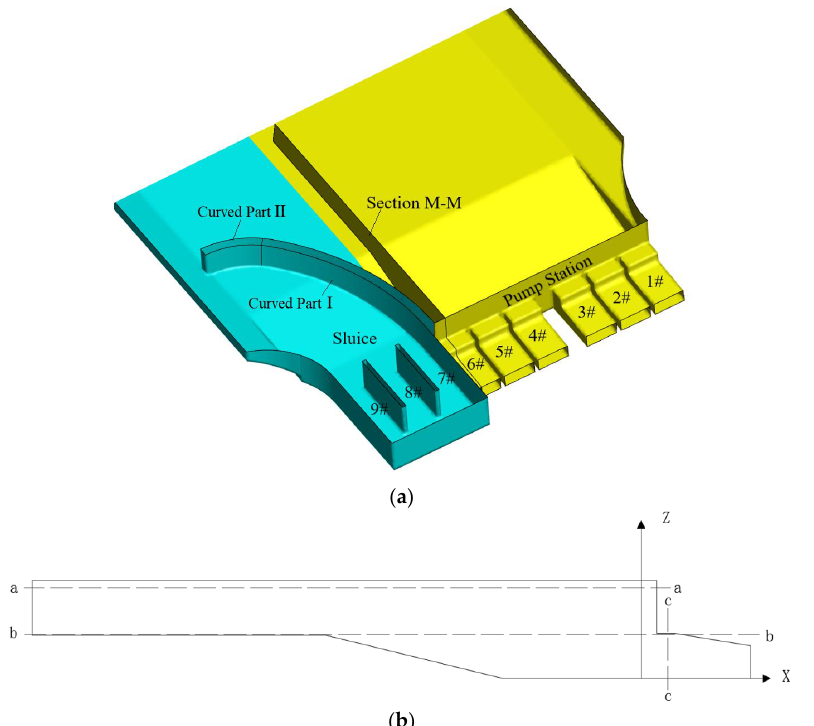
Figure 13. Diagrammatic sketch of the position of characteristic section under the pumping condition: ( a ) diagrammatic sketch of the position of characteristic section M-M; ( b ) sectional profile M-M.